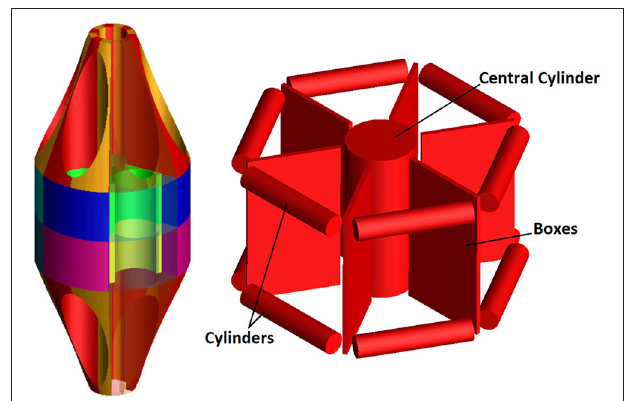
FIGURE 3 | Ring Models: segmented ring (Left); “conceptual” ring (Right) .